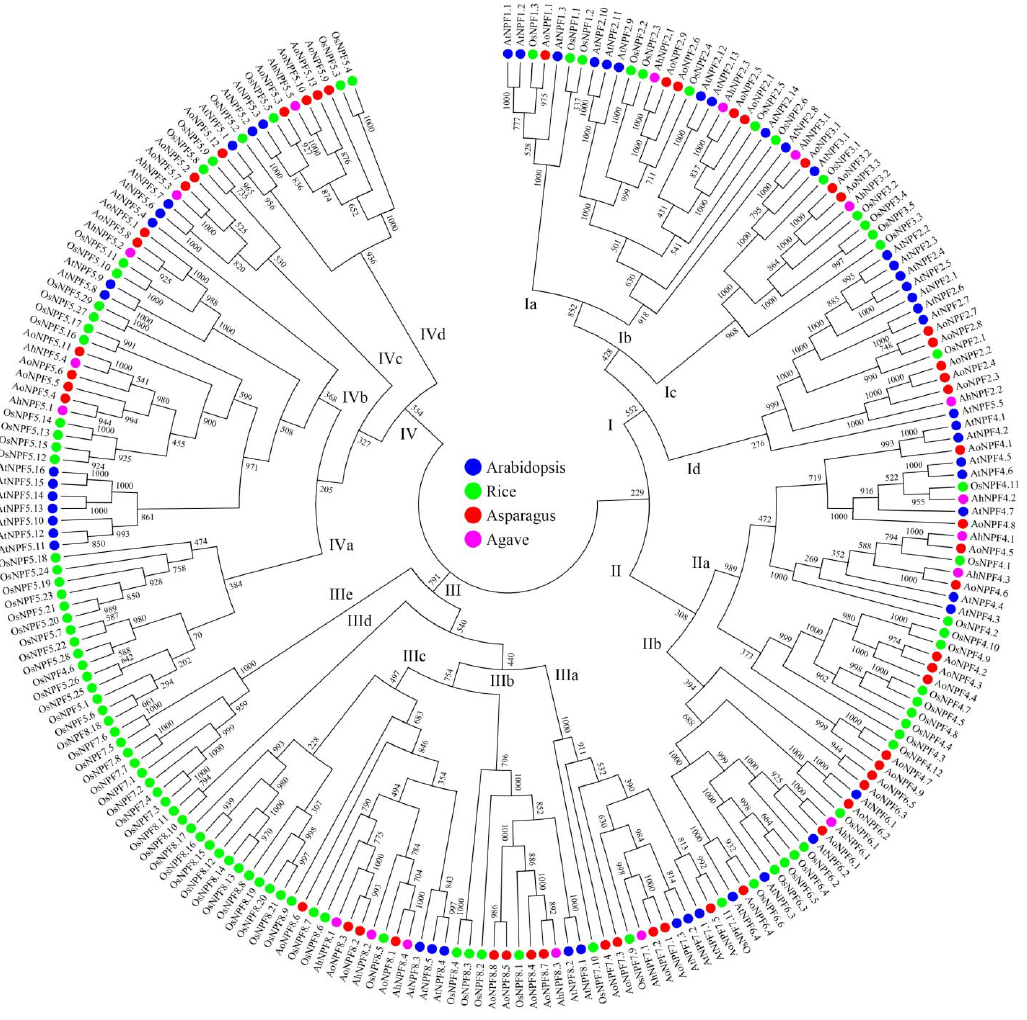
Figure 1. Phylogenetic analysis of NPF family. The protein names of arabidopsis, rice, asparagus and agave are labeled in blue, green, red and pink, respectively.